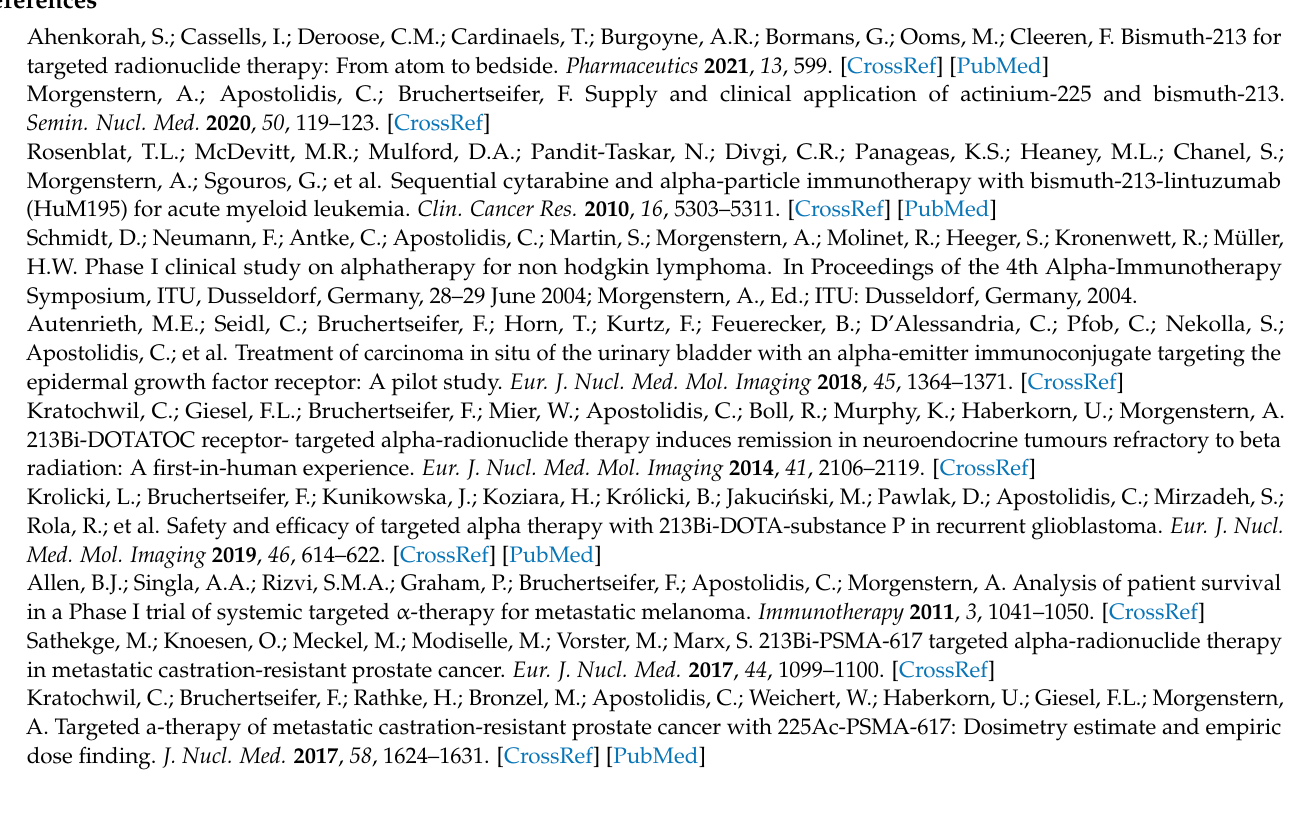
Figure A1. Initial distribution of 225 Ac in the AG MP-50 column of 225 Ac/ 213 Bi generator.